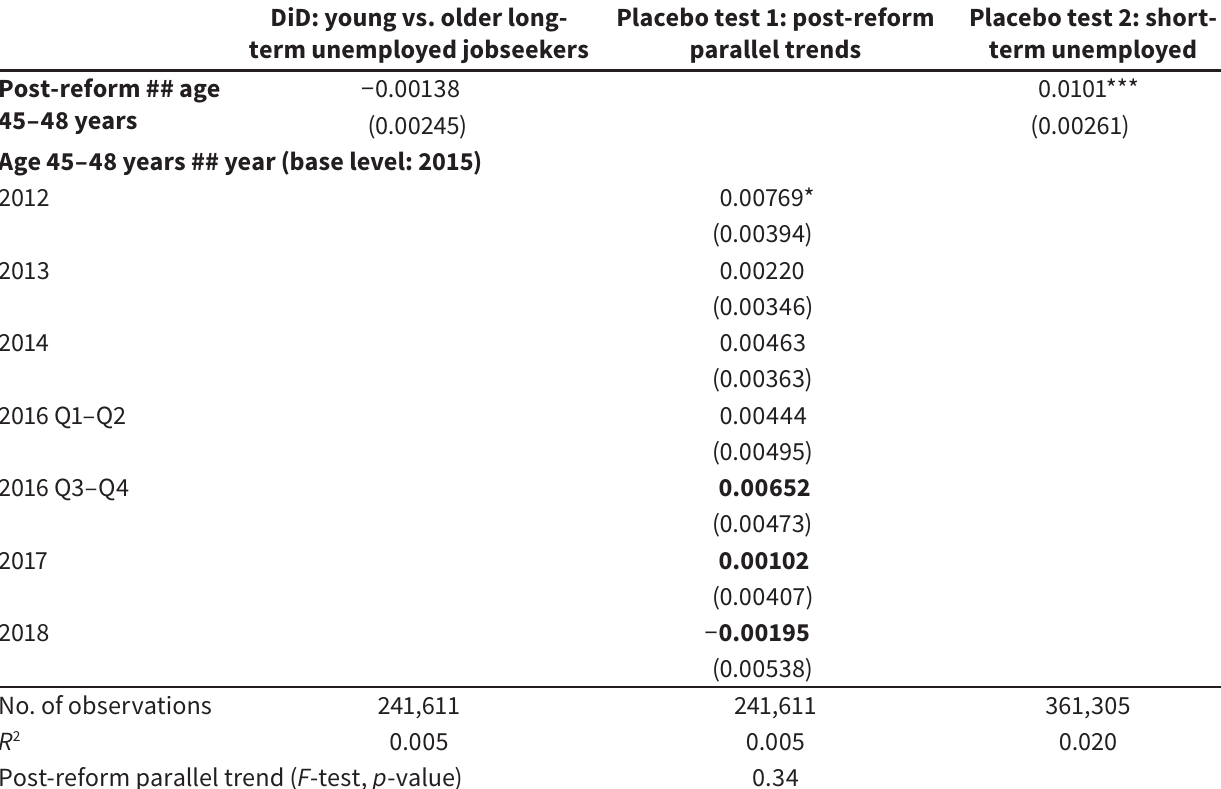
DiD exploiting differences across age groups for the long-term unemployed and placebo tests DiD: young vs. older long- Placebo test 1: post-reform Placebo test 2: term unemployed jobseekers parallel trends